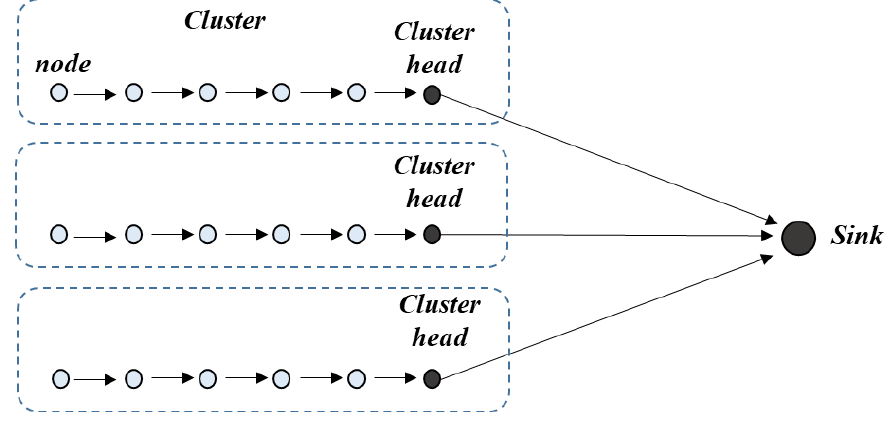
Figure 9. Routing pattern of the 1-D network.